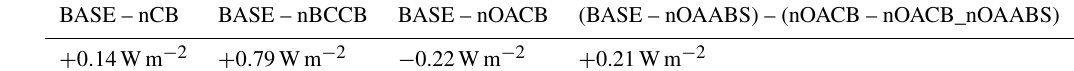
Table 4. The DRE differences (Wm − 2 ) between the cases at TOA during the summer harvest (1–21 June) in 2013.